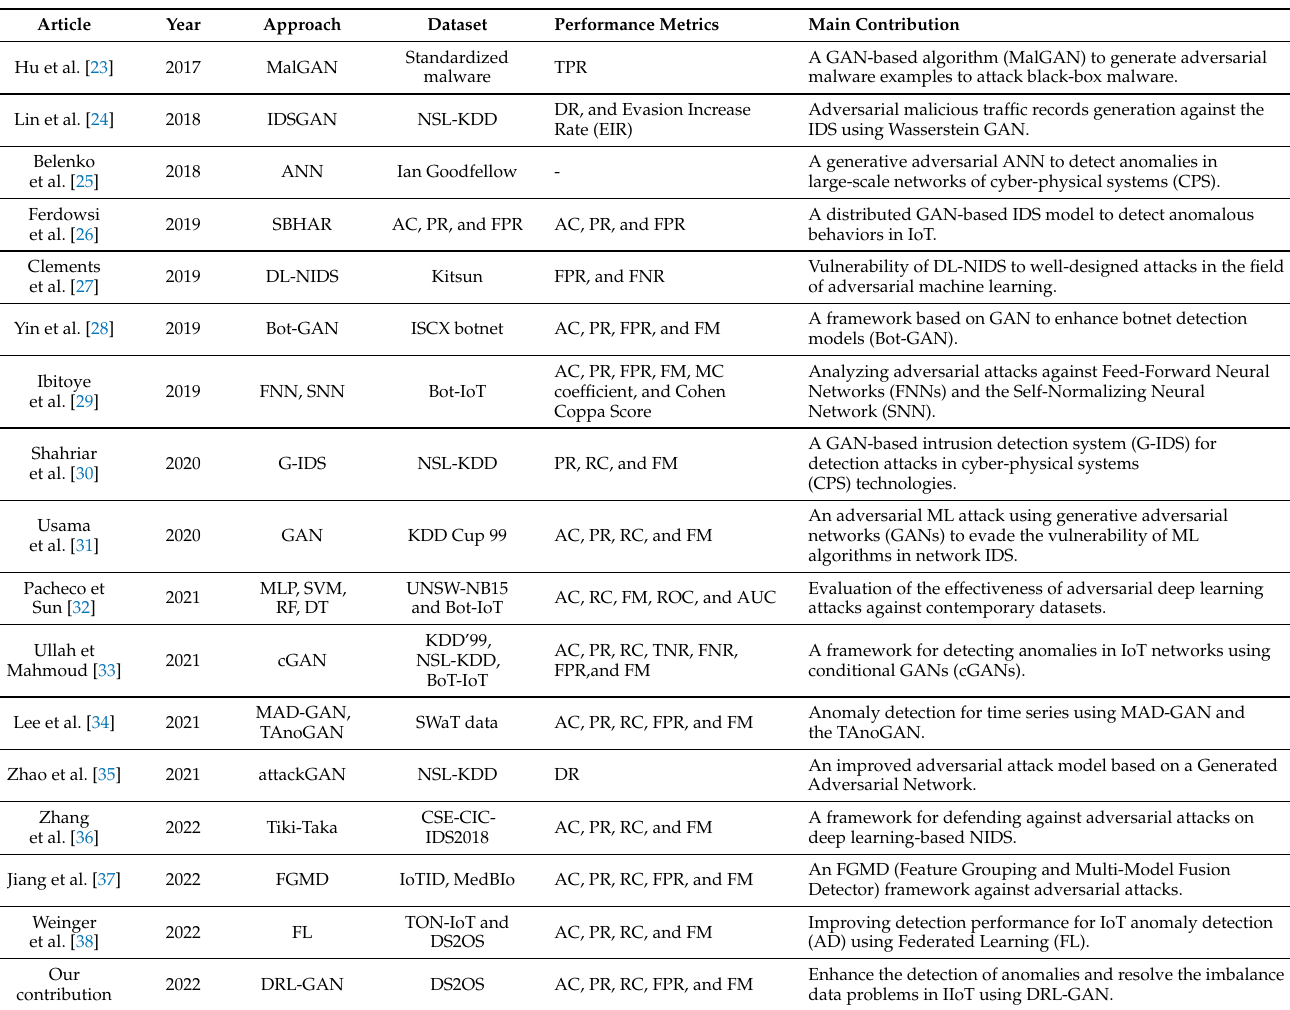
Table 1. Summary of the most relevant adversarial attacks based on IDS models in the